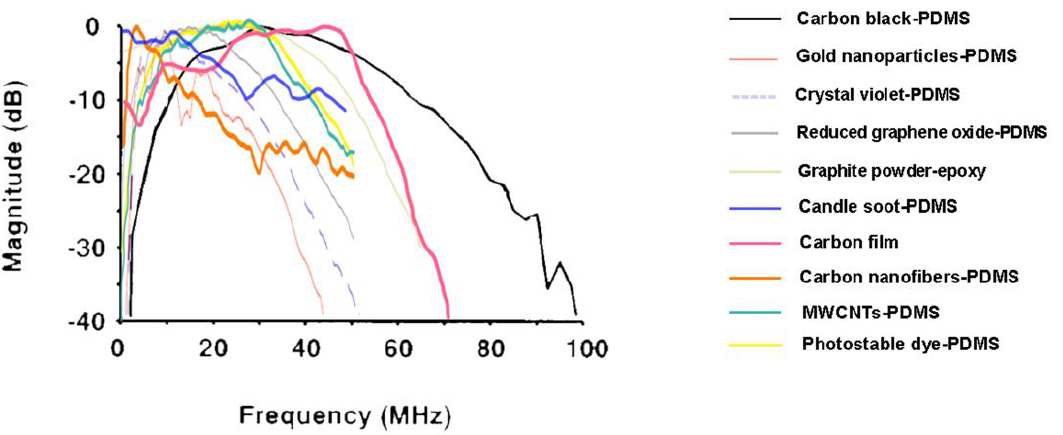
Figure 13. Normalized ultrasound power spectra of several materials used for photoacoustic-based ultrasound transmitters. Adapted from [61,82,110,118,120,123,125,126,133].